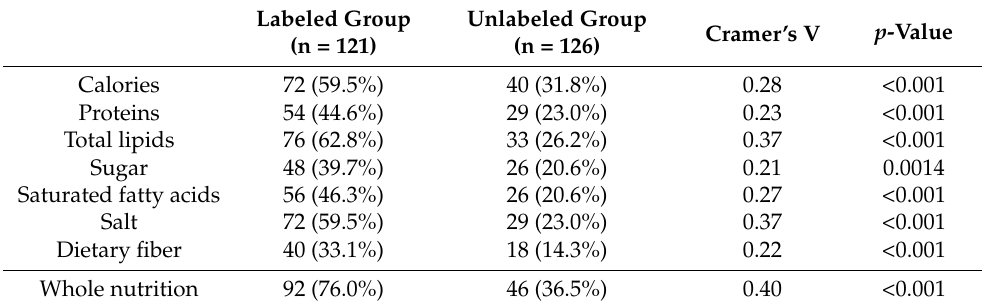
Table 3. Nutritional awareness when choosing